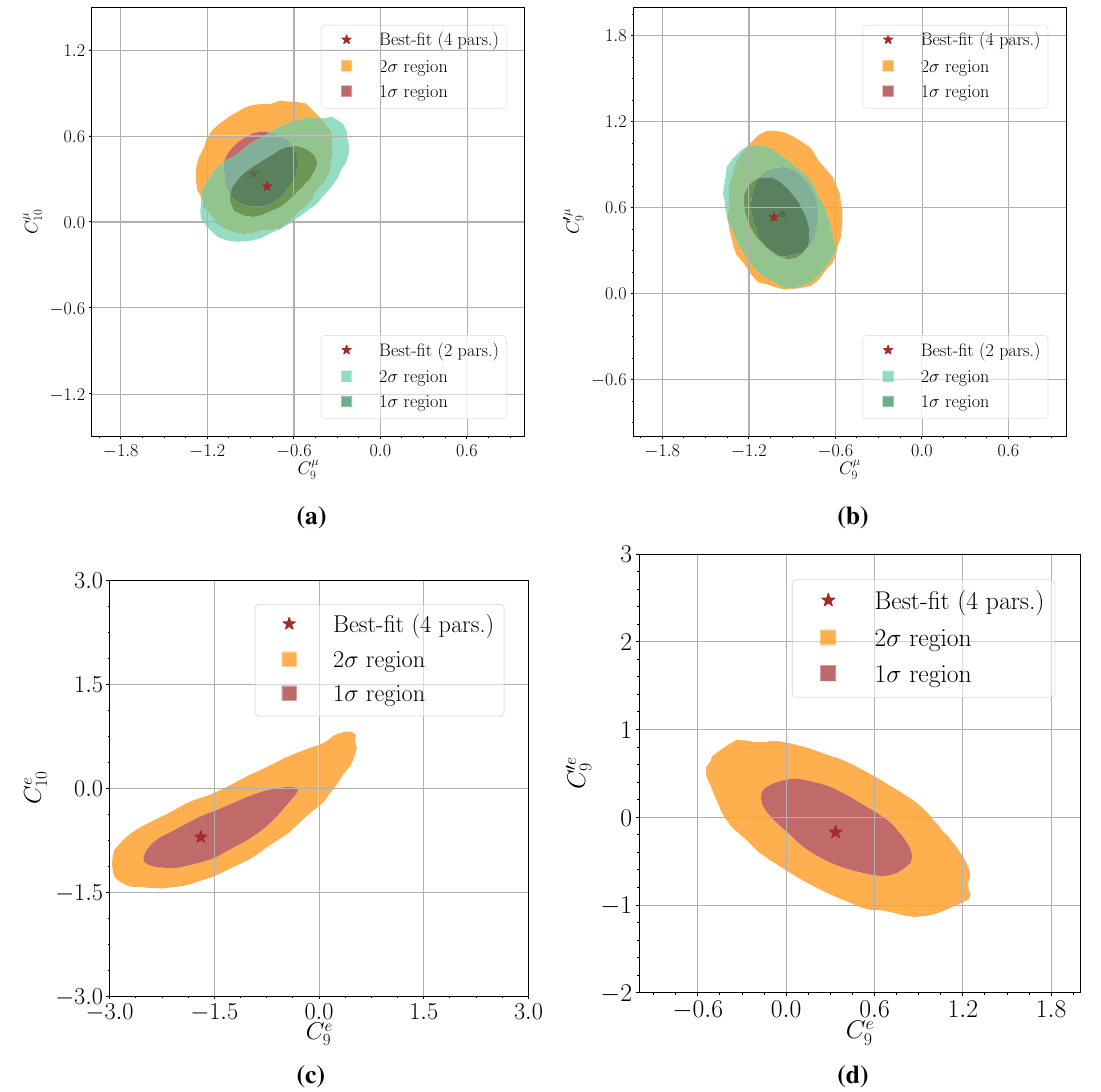
μ (cid:4) μ , C (fourth row of Table 2, in 9 9 μ (cid:4) μ , C , C e , C (cid:4) e all floating (seventh 9 9 9 9 μ μ , C e for the scan with C , C , C e , C e all float- 9 10 9 10 9 10 , C (cid:4) e for 9 9 μ (cid:4) μ , C , C e , C (cid:4) e all 9 9 9 9